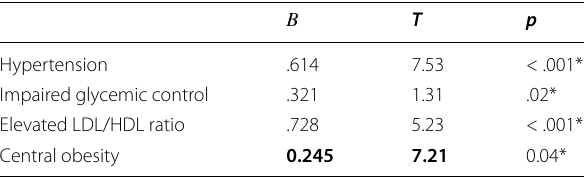
Table 5 Linear regression for prediction of Log atypical energy- related symptoms dimension